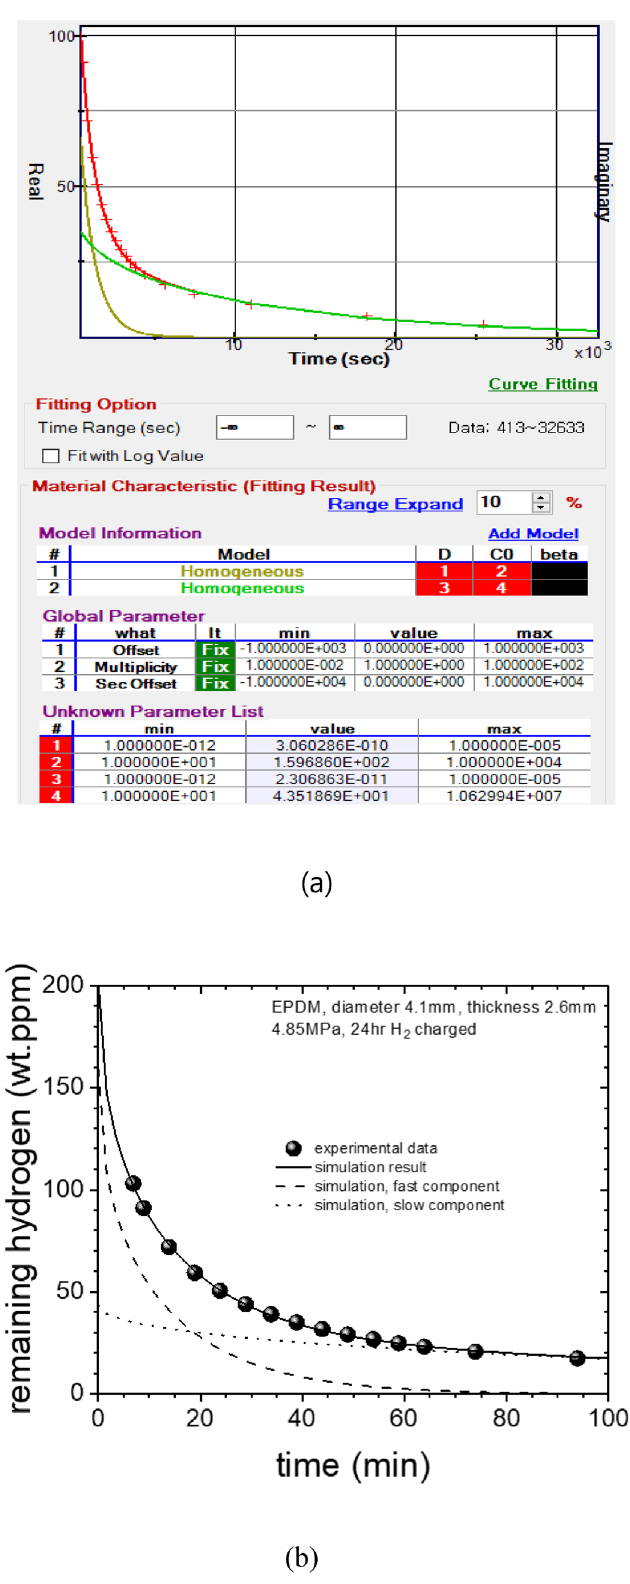
Figure 7. ( a ) The image of analysis program showing two kinds of diffusion behaviors. The parameters, D and C H0 are the diffusivity and the residual hydrogen content, respectively. ( b) Experimental data (symbols) of residual hydrogen concentration and simulation results (dashed- and